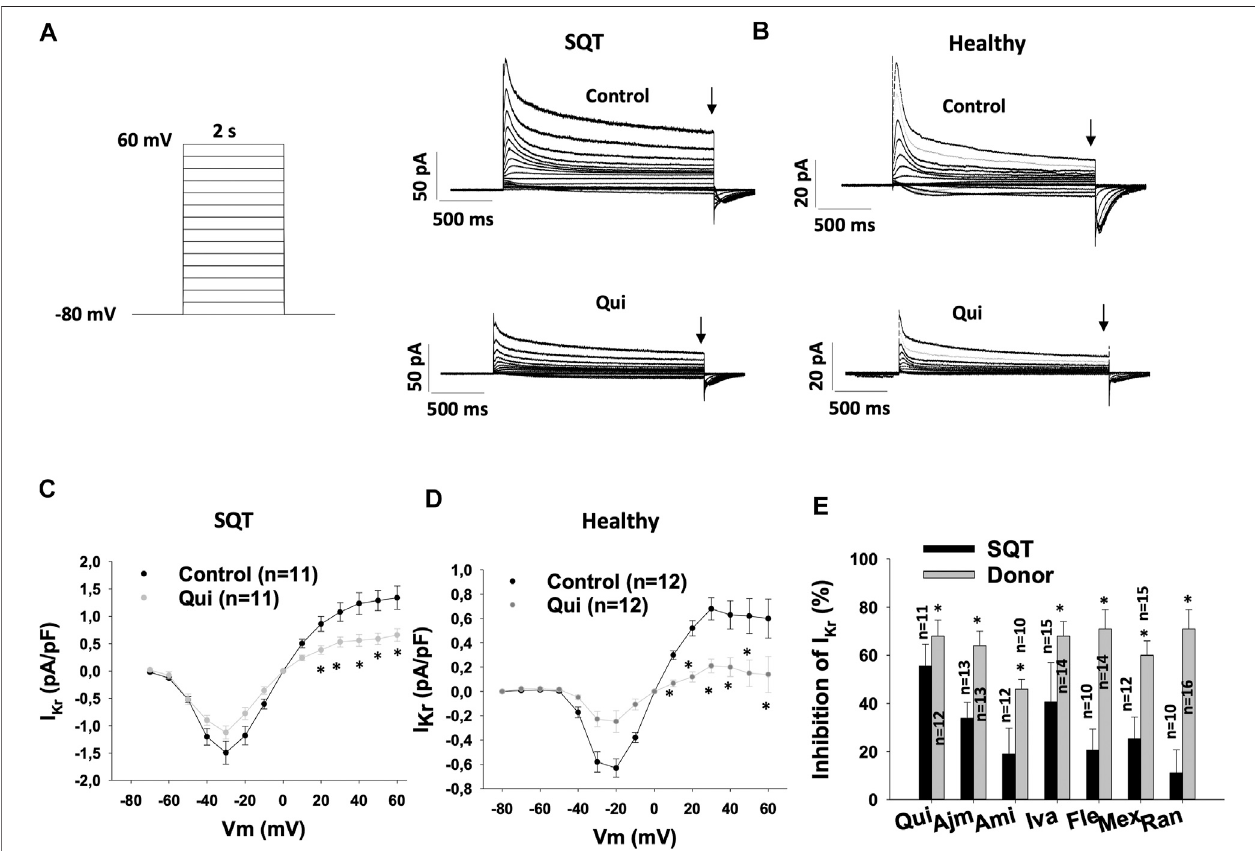
FIGURE1| DrugeffectsonI Kr inSQTS1-hiPSC-CMs.I Kr wasevokedby2 spulsesfrom − 80to60 mV(10 mVincrements)withaholdingpotentialof − 80 mV.The steady state currents were measured at the end of pulses as indicated by arrows in (A) and (B) in the same cells before and after application of a drug. (A) The protocol (rightside) andrepresentativeI Kr traces (leftside) inabsence(Control)andpresenceof10 µMquinidine(Qui)inaSQT1-hiPSC-CM(SQT). (B) RepresentativeI Kr traces in absence (Control) and presence of 10 µM quinidine (Qui) in a donor-hiPSC-CM (Healthy). (C) Current-voltage relationship (I-V) curves of I Kr in absence (Control) and presence of 10 µM quinidine (Qui) in SQT1-hiPSC-CMs (SQT). (D) I-V curves of I Kr in absence (Control) and presence of 10 µM quinidine (Qui) in donor-hiPSC-CMs (Healthy). (E) Averaged values of percent inhibition of I Kr at 40 mV by quinidine (Qui, 10 µM), ajmaline (Ajm, 30 µM), amiodarone (Ami, 10 µM), ivabradine (Iva, 10